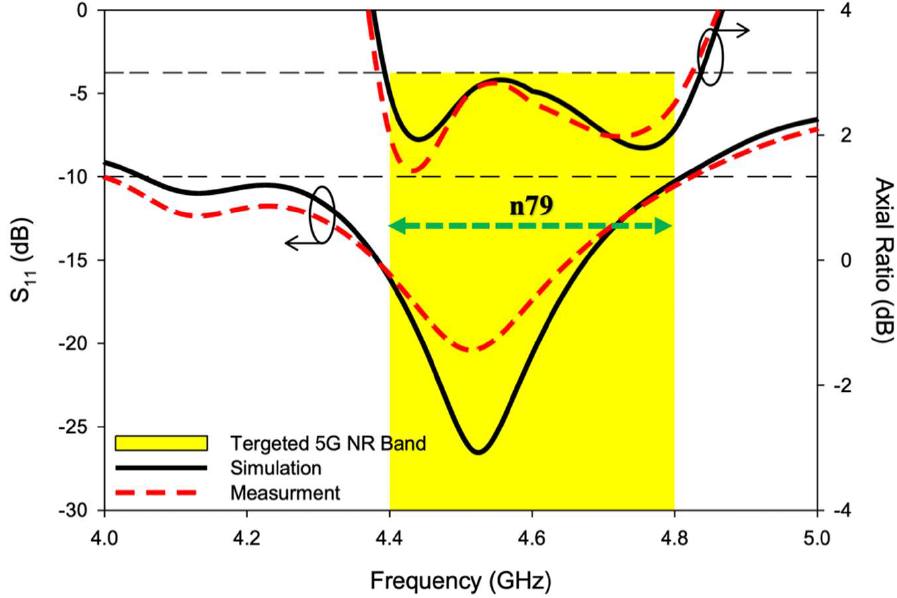
Figure 14. Simulated and measured S 11 and AR overlapping bandwidths of the CP 5G RDRA. Figure 13. Simulated and measured axial ratio of the CP 5G RDRA. The simulated and measured radiation patterns of the proposed CP 5G RDRA are presented in Figure 15. The radiation patterns were computed and measured at three different frequencies. The antenna provided stable radiation patterns with left-hand circular polarization, since the left-hand field component was greater than the right-hand field component by a margin of more than 20 dB at minimum AR frequency i.e., 4.43 GHz, as shown in Figure 15b. The right-hand CP response could be achieved by reversing the feeding strip. The simulated and measured gain of the CP antenna are shown in Figure 16. The antenna offers a useful gain of ~6.2 dBic throughout the CP bandwidth. This high gain was achieved by excitation of the higher-order mode. A reasonable resemblance was observed between simulated and measured results.